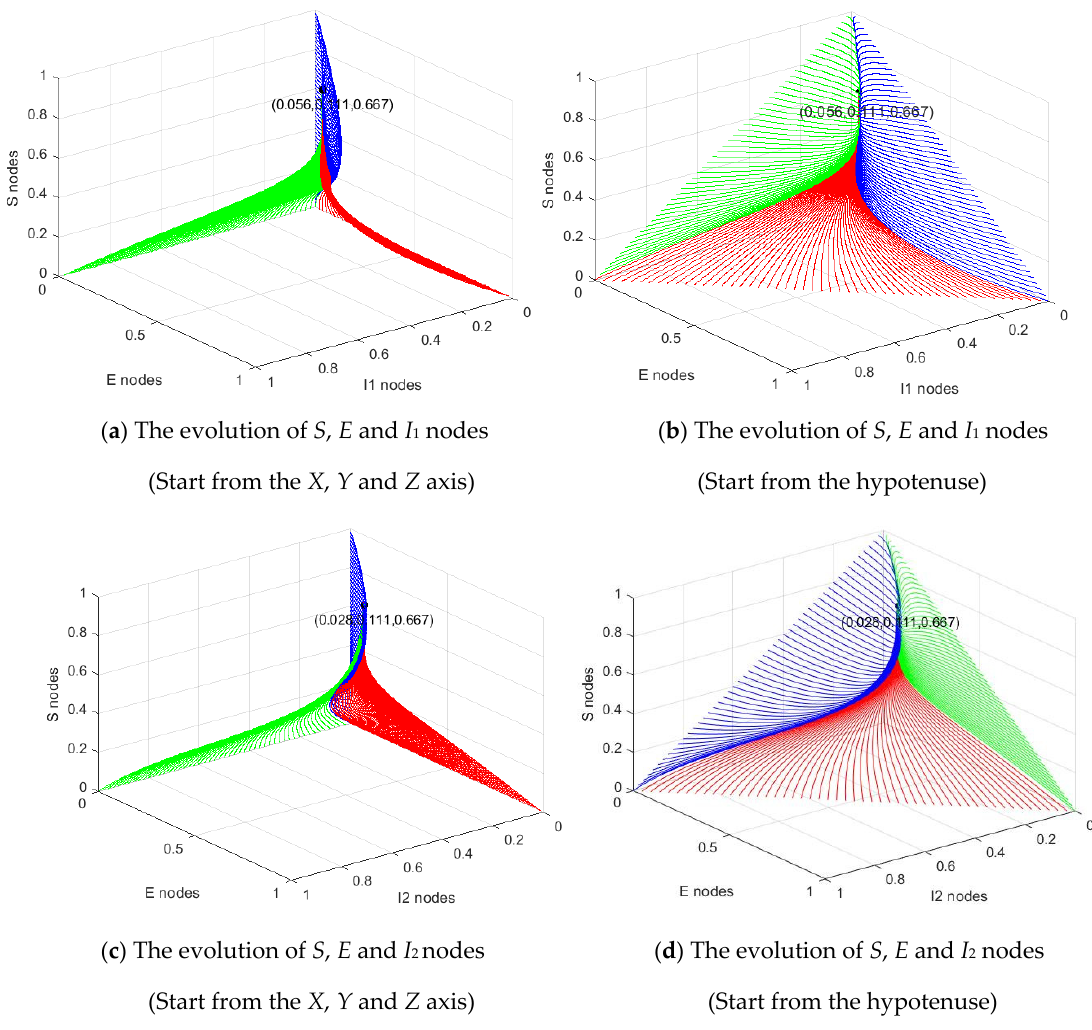
Figure 3. The evolution of state variables when R 0 >1.